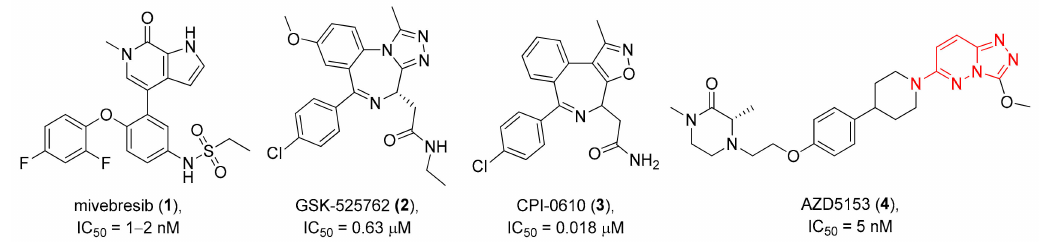
Figure 1. Investigational drugs—bromodomain 4 (BRD4)